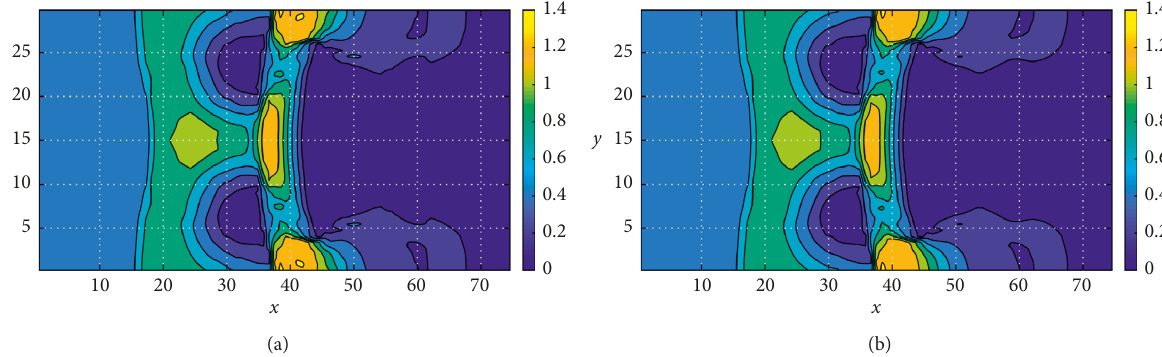
Figure 15: Contour plots of h using 85